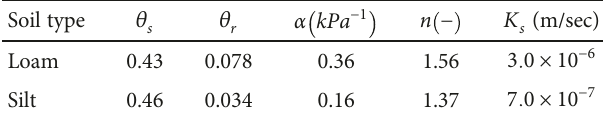
Table 1: Hydraulic properties of soil (Carsel and Parrish, 1988).